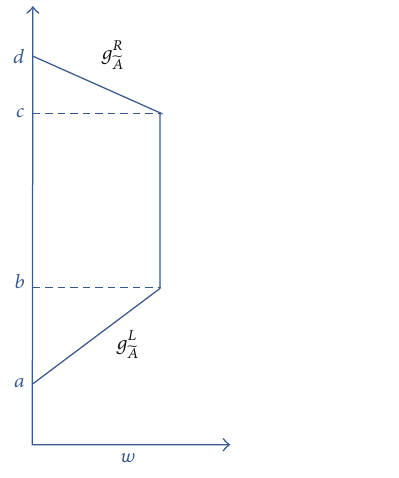
Figure 4: Reciprocal memberships function of a trapezoidal fuzzy